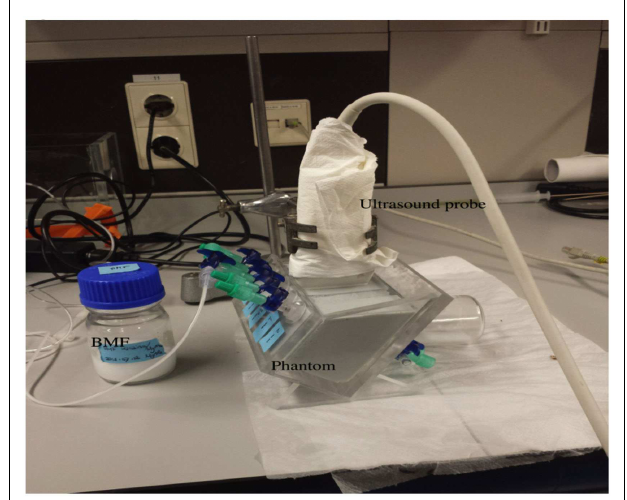
FIGURE 1 |The test setting . Flow phantom with a fixed ultrasound probe. BMF, blood-mimicking